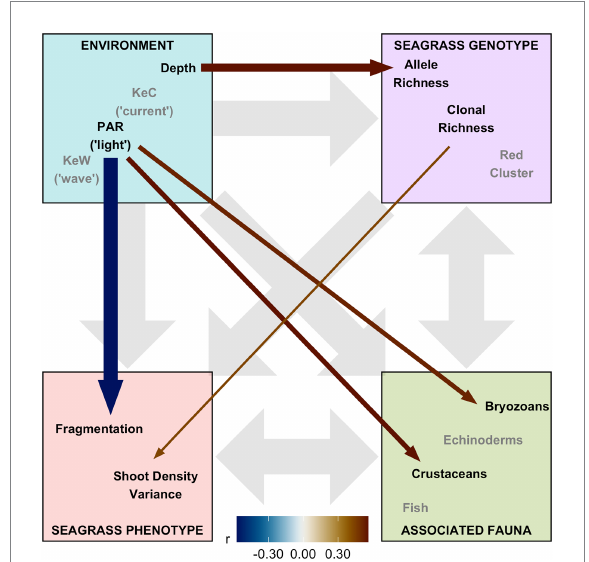
FIGURE 5 Structural equation model (SEM) schematic representation of Zostera marina ecosystem linkages from 17 locations across the south coast of England. Thirteen covariates were assigned to four ecosystem components: “environment,” “seagrass genotype,” “seagrass phenotype,” and “associated fauna.” Gray background arrows show assumed causal or bidirectional associations between ecosystem components. Covariates shown with black text were those found to have statistically significant associations with other components within our SEM ( p < 0.01), and remaining covariates in the model shown with gray text. Colored foreground arrows show the magnitude and direction ( − ve blue, red +ve) of associations, with arrow width scaled by statistical significance (smaller p -value shown as wider